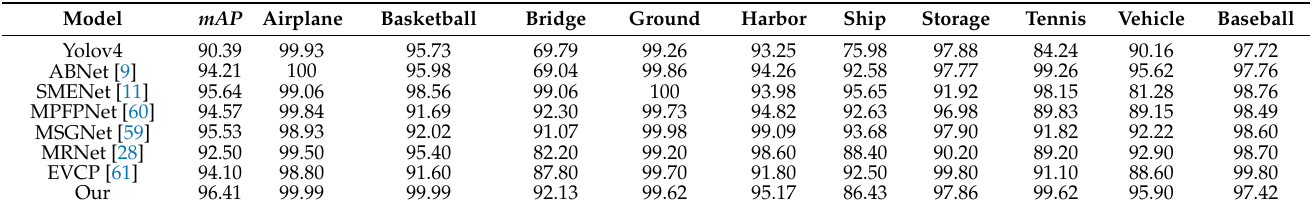
Table 5. Accuracy comparison of our proposed model with other advanced models available, using the NWPU VHR-10 dataset.